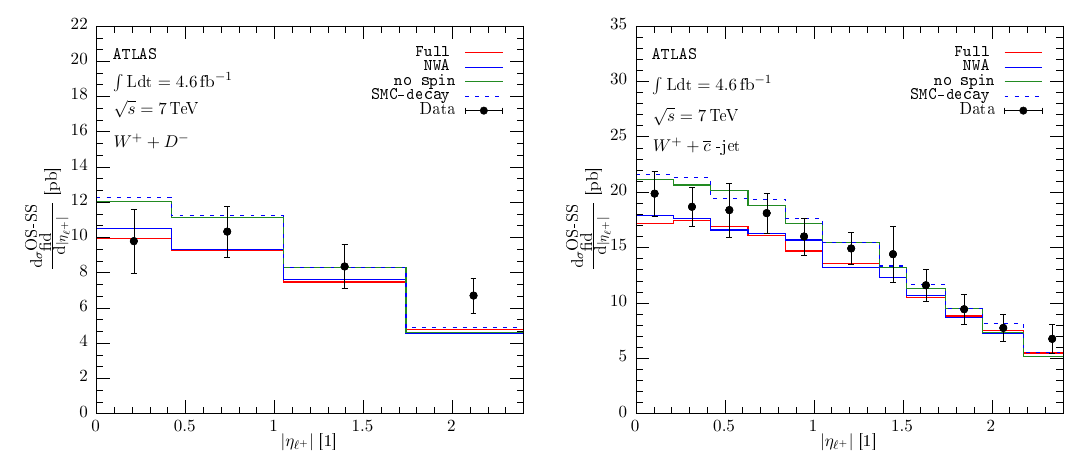
Figure 14 . Same as in figure 13, but for the PYTHIA8 Monash